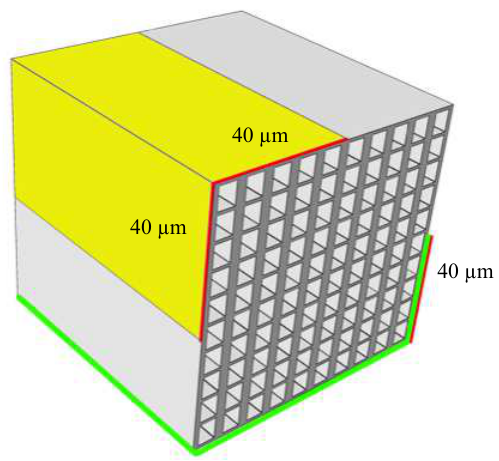
Figure 5. Orthoslice projections in the different planes of a rhodolith thallus: (a) xy direction; (b) xz direction; (c) yz direc- tion and (d) in 3-D format. The purple box highlights where the 80µm × 80µm cube was selected.